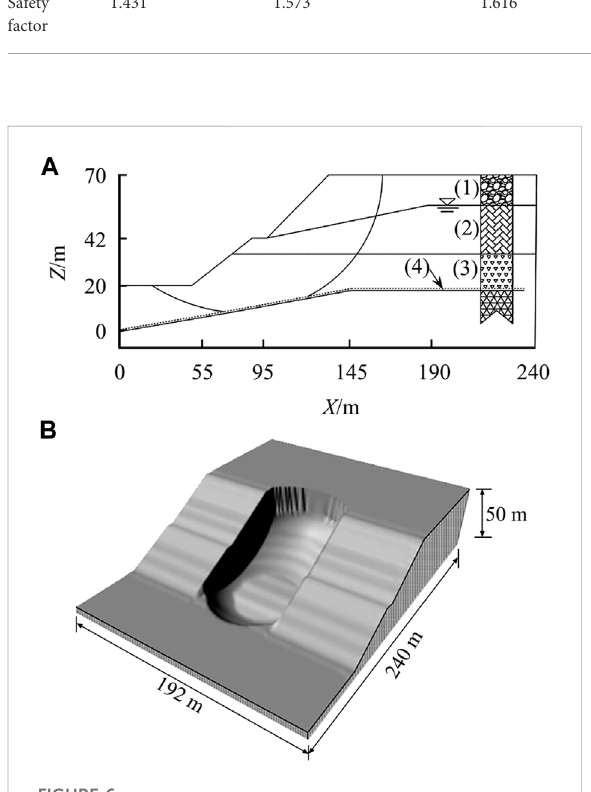
FIGURE 6 Slope example 2. (A) Cross section of slope, (B) The DEM model on the surface of the